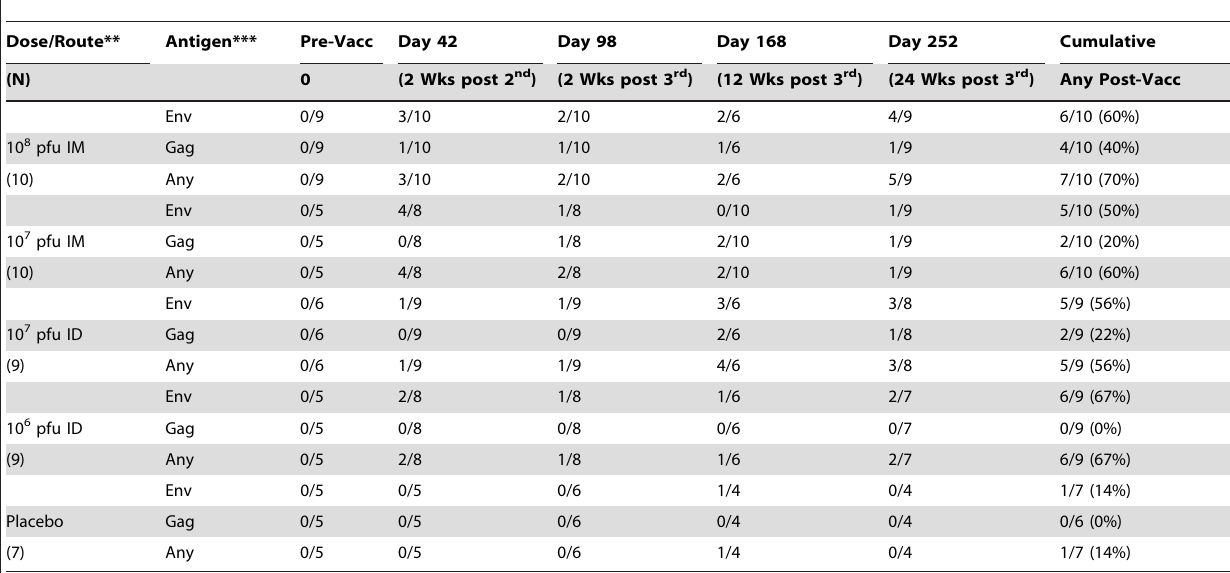
Table 2. Cross-sectional frequency of positive CD8 CTL responses as measured in the 51 Cr-release assay.